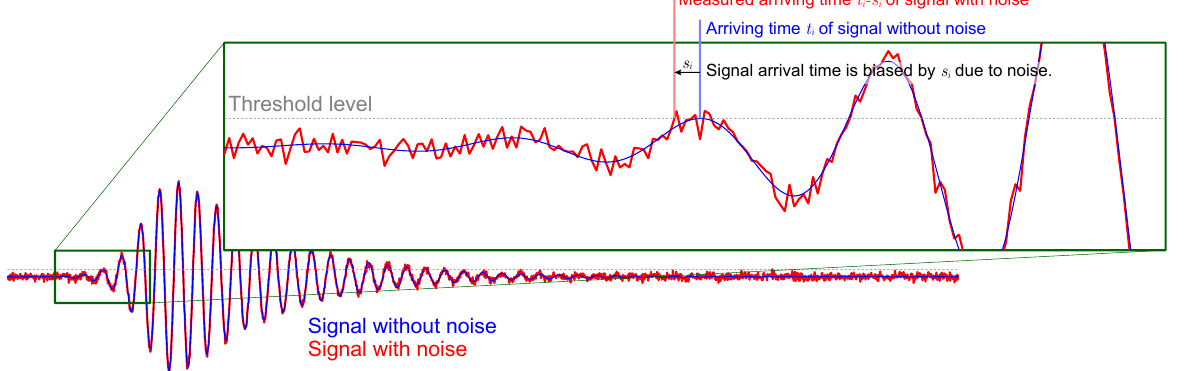
Figure 2. Illustrative figure of the simulated AE signal. The presence of noise in the AE signal changes the signal arrival time, which is determined by the